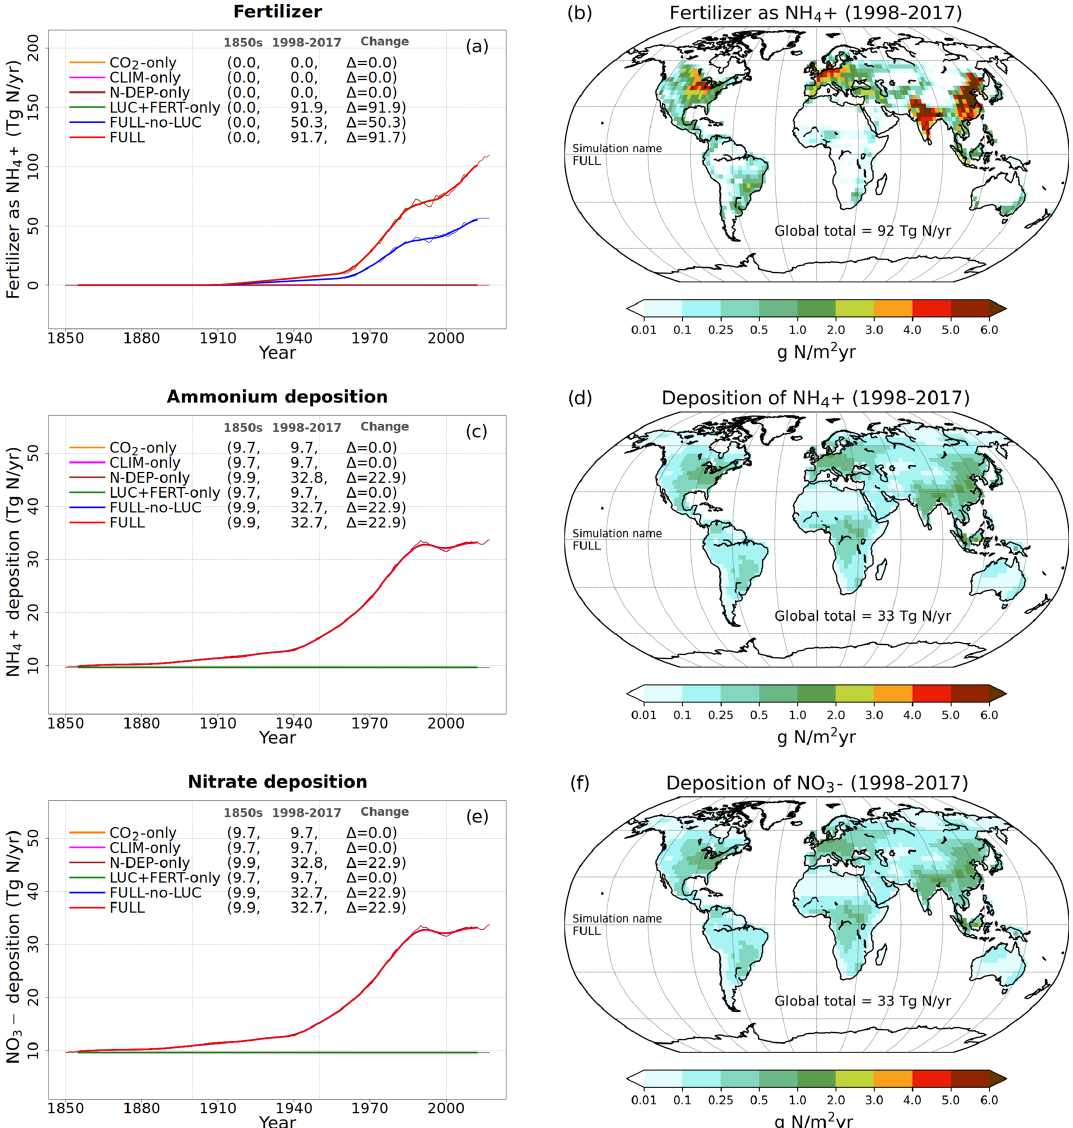
Figure 2. Time series and geographical distribution of global annual values of externally specified N inputs. Fertilizer input (a, b) , atmo- spheric deposition of ammonium (c, d) , and atmospheric deposition of nitrate (e, f) . The values in the parentheses for legend entries show the average for the 1850s, the average for the 1998–2017 period, and the change between them. The thin lines in the time series plots show the annual values, and the thick lines show their 10-year moving average. The geographical plots show the average values over the last 20 years of the FULL simulation corresponding to the 1998–2017 period. Note that in the time series plots, lines from some simulations are hidden behind lines from other simulations, and this can be inferred from the legend entries which show averages for the 1850s and the 1998–2017